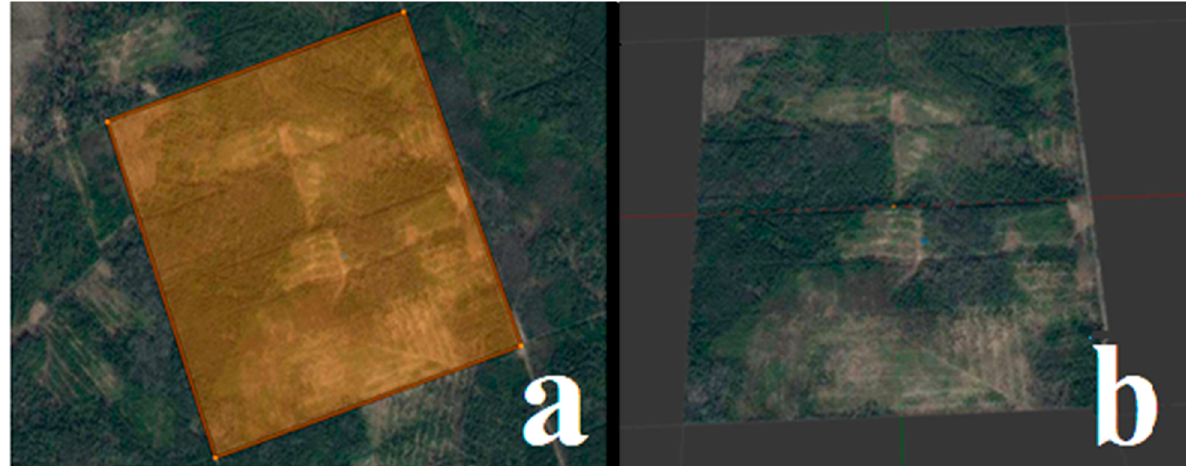
Figure 2. Result of image import and UV mapping: ( a ) selected area; ( b ) localized part. Blender has a UV transform function; UV transform or unfolding in three-dimensional graphics (UV-map) is the correspondence between the coordinates on the surface of a three-dimensional object (X,Y,Z) and coordinates on a texture (U,V). The U and V values usually range from 0 to 1. We proceeded to create a weight map using UV transform after refining and selecting the forest-covered area.